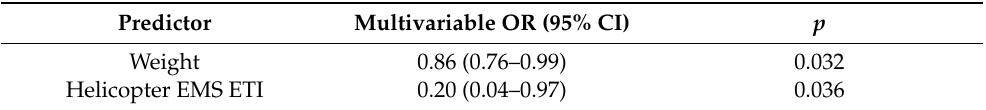
Figure 3. Univariable associations with tracheal tube misplacement. Table 3. Significant adjusted predictors identified in a stepwise logistic multivariable regression model of associated factors with tracheal tube